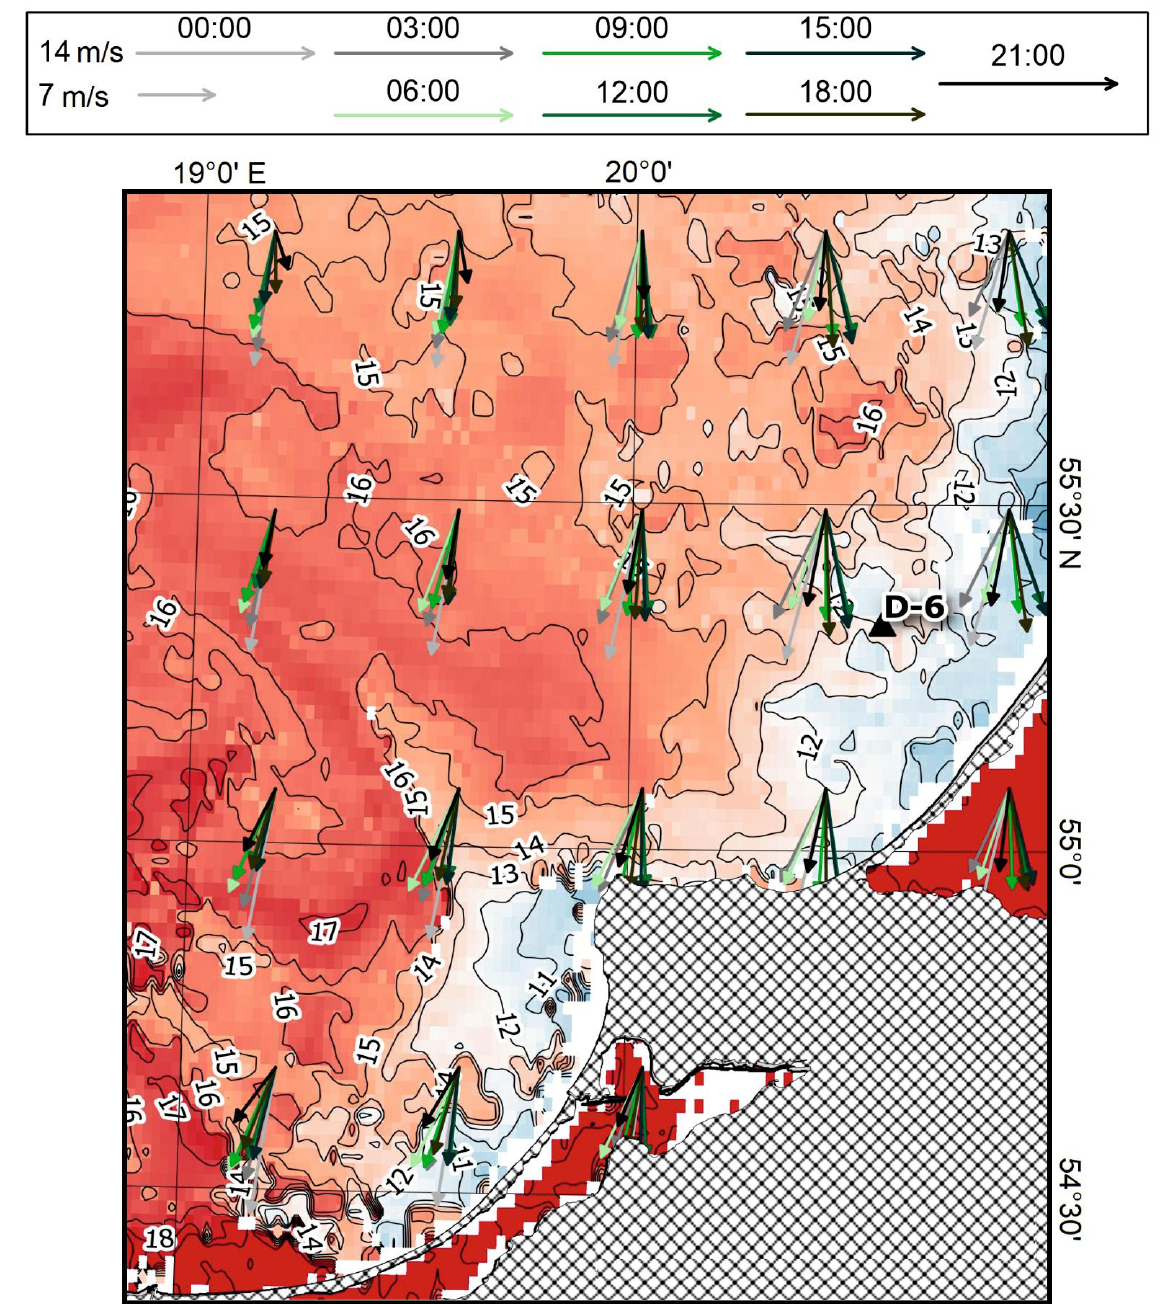
Figure 6. Wind speed and direction for 6 June 2016, and surface water temperature according to satellite data for 00:00 on 7 June 2016. Upper panel is a legend for the wind data.